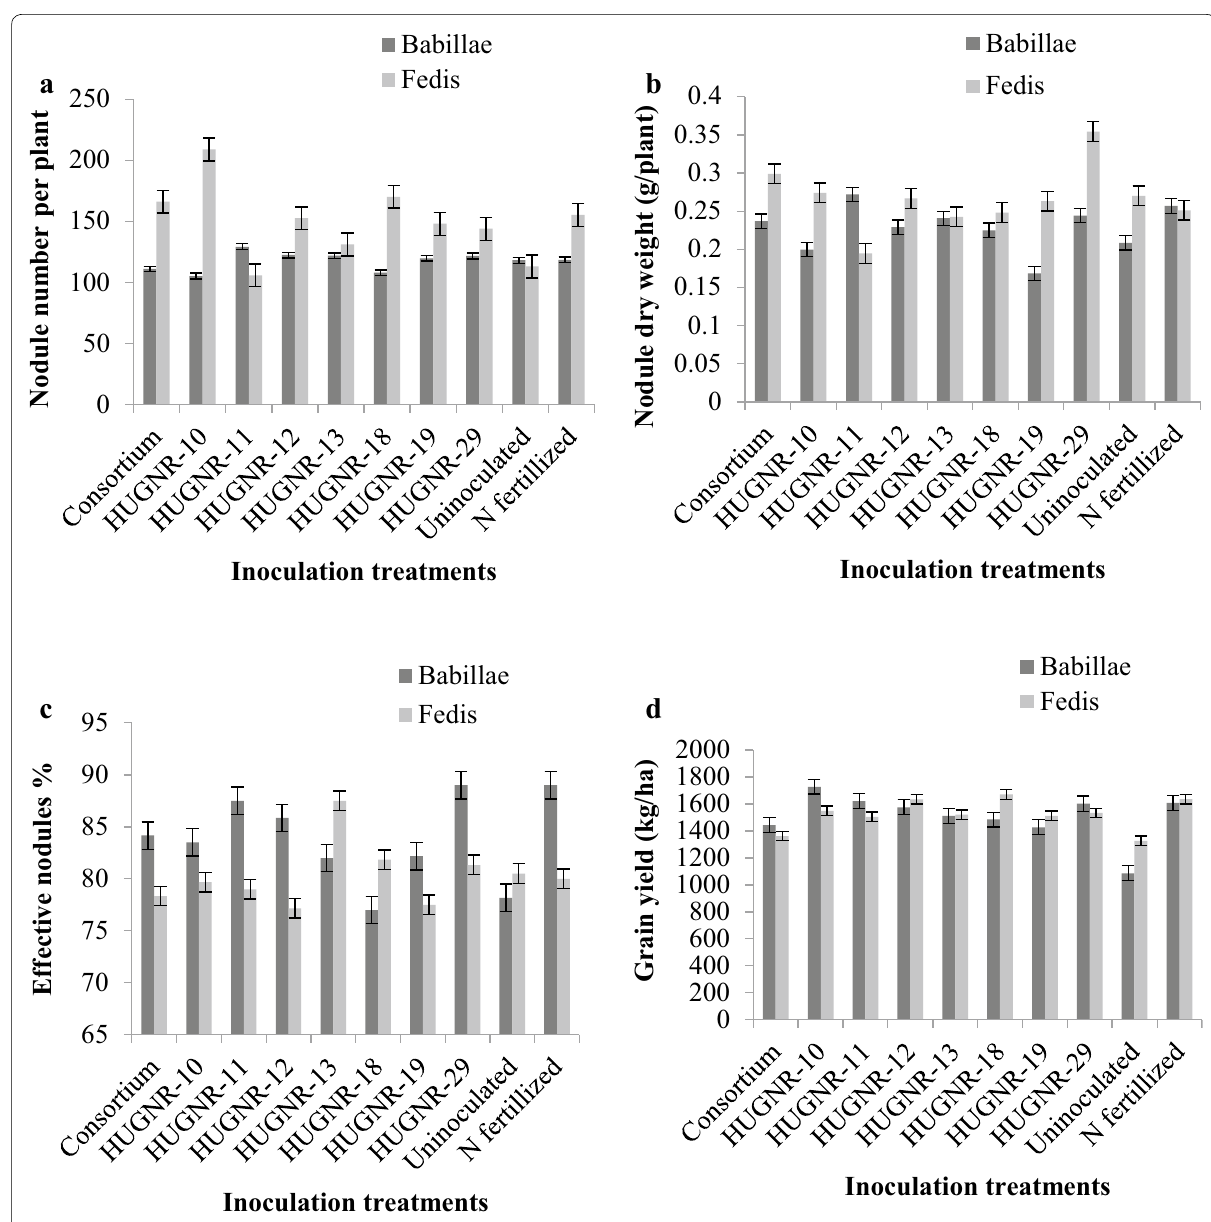
Fig. 1 Effect of Bradyrhizobium inoculation on a Nodule number, b Nodule dry weight, c Effective nodules % and d Grain yield of peanut at Babile and Fedis experimental